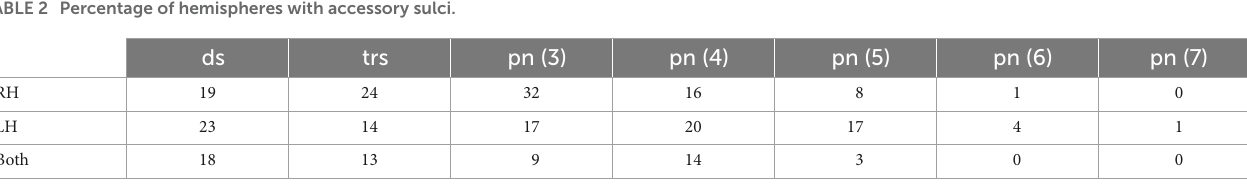
TABLE 2 Percentage of hemispheres with accessory